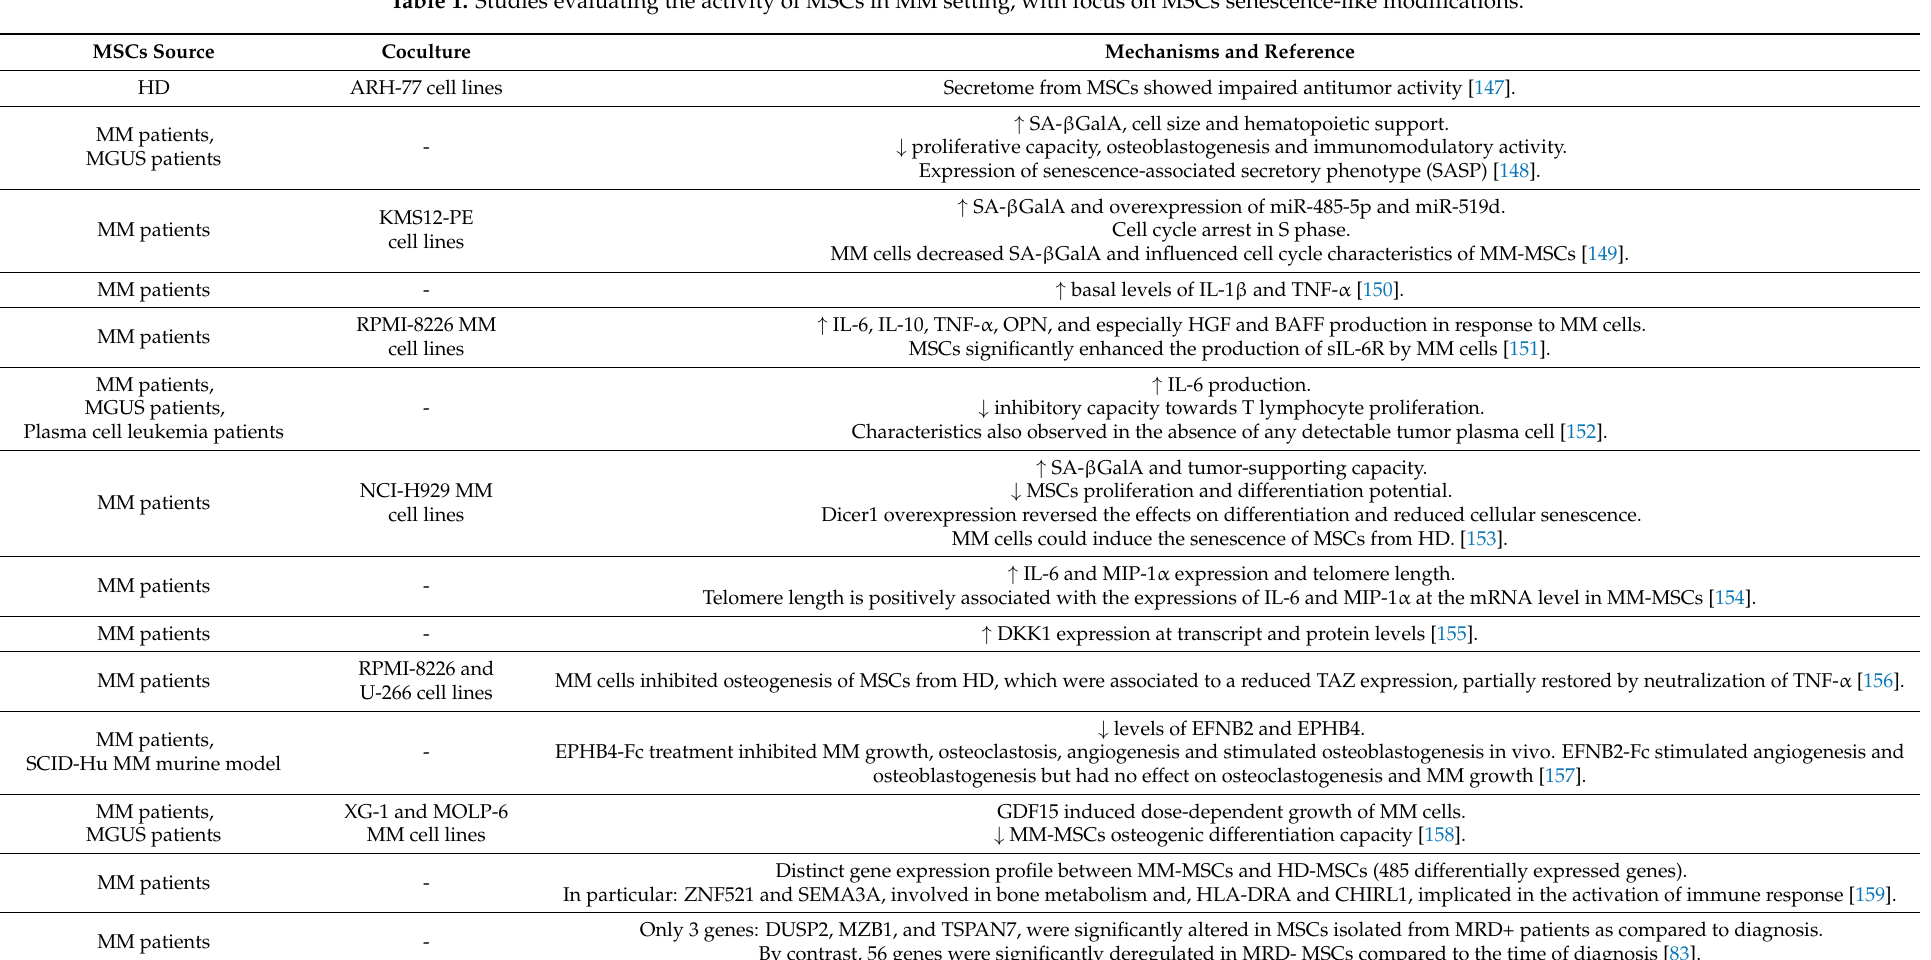
Table 1. Studies evaluating the activity of MSCs in MM setting, with focus on MSCs senescence-like